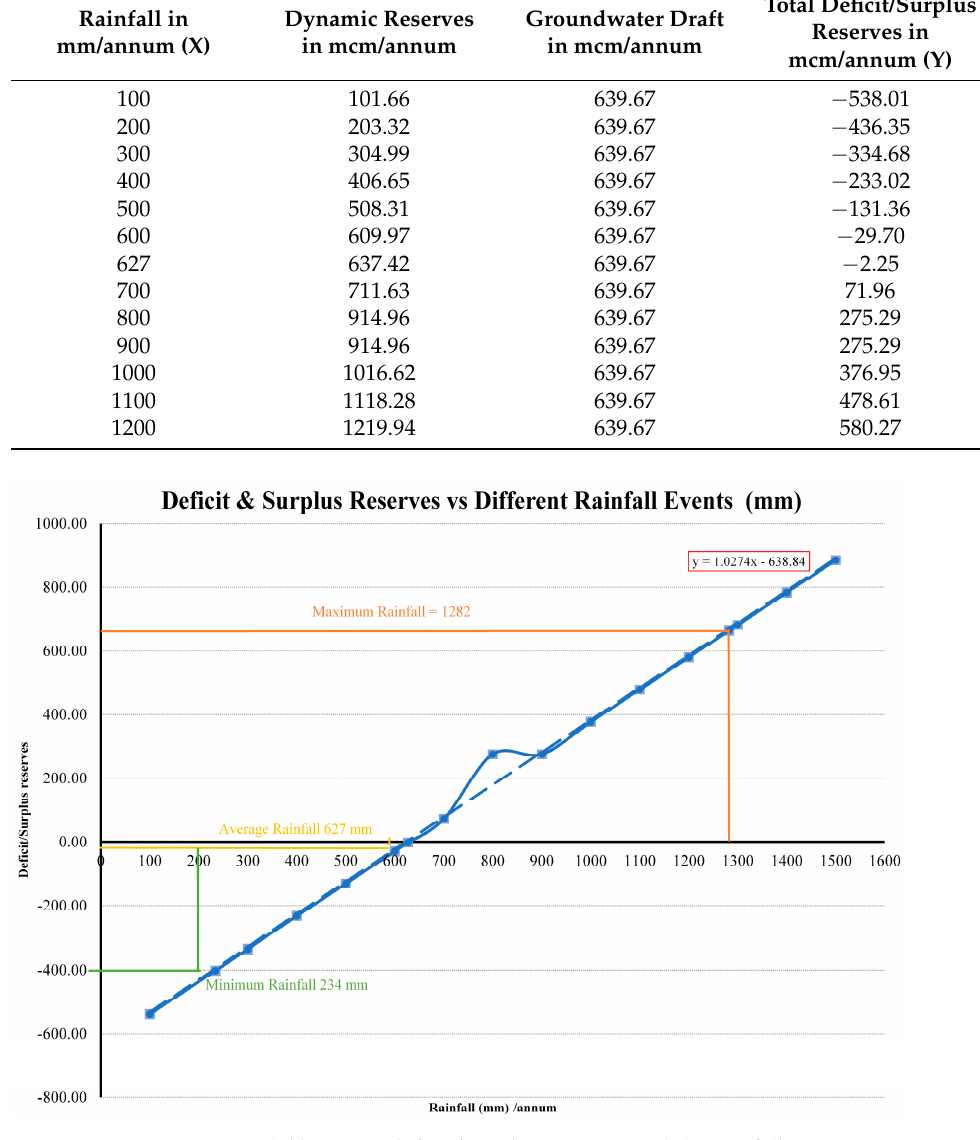
Figure 23. Regression model between deficit/surplus reserves and the rainfall.